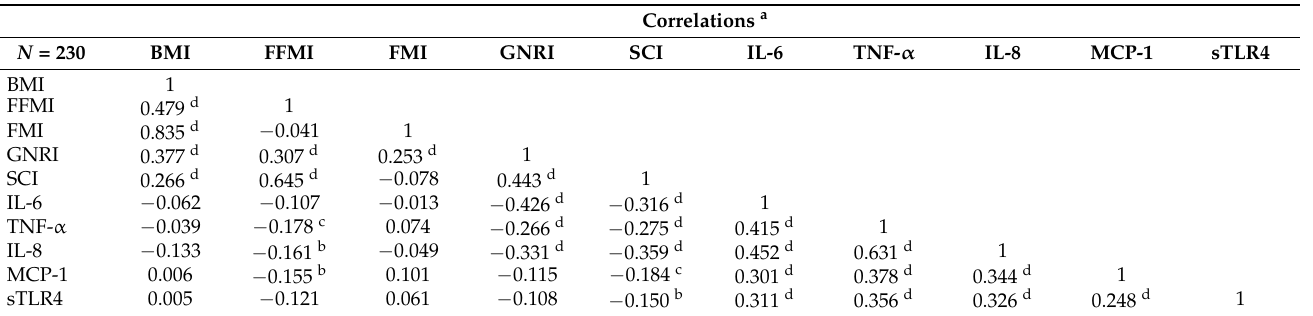
Table 2. Correlation among body composition, circulating inflammatory markers, geriatric nutritional risk index, and simplified creatinine index in adults undergoing maintenance hemodialysis.